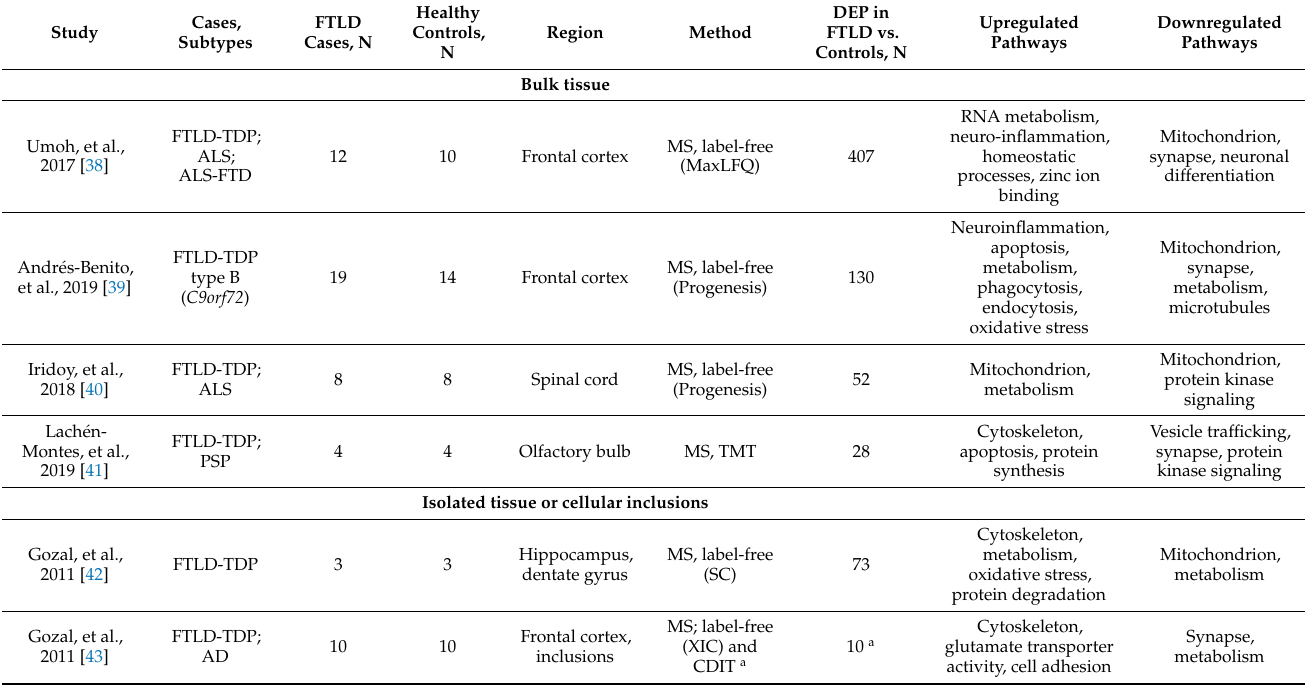
Table 1. Unbiased proteomic studies of FTLD-TDP brain tissue, including their main findings. Studies are ordered according to study design. All studies included FTLD-TDP cases and healthy controls, and some also included other disease types. A few studies included specific TDP subtypes, but most did not specify the subtype. The major pathways are provided for FTLD-TDP cases as compared to healthy controls, as reported by the studies. Some included both upregulated and downregulated proteins. Abbreviations: FTLD-TDP, frontotemporal lobar degeneration with TDP-43 pathology; DEP, differentially expressed proteins; ALS, amyotrophic lateral sclerosis; PSP, progressive supranuclear palsy; MS, mass spectrometry; TMT, tandem mass tag; SILAC, stable isotope labeling with amino acids in cell culture; CDIT, culture-derived isotope tags; SC, spectral counts; XIC, extracted ion chromatogram; IMAC, immobilized metal affinity chromatography. Progenesis and MaxLFQ are both software packages to perform label-free quantitation. a This study performed two independent MS strategies, and focused on the overlapping proteins of both datasets. b A distinct set of proteins was identified for each TDP subtype, but TDP-43 protein was detected in all